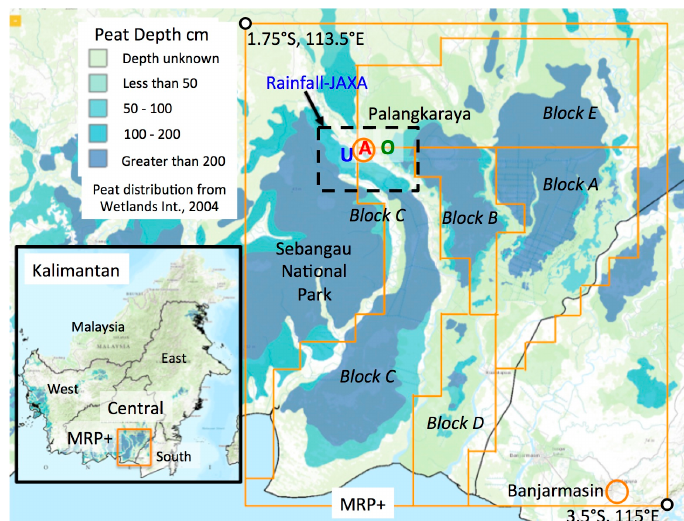
Figure 1. Study area, MRP+ and Kalimantan. mega rice project (MRP)+ cover area: 1.75–3.5 S, 113.5–115 E; A: Tjilik Riwut Meteorology Station (TRMS) (2.226 S, 113.95 E); U: groundwater level (GWL) measured site (2.32 S, 113.9 E); O: OLR reference point (2.21 S, 114 E) ; dotted line rectangle: reference area for JAXA rainfall; base peat depth map: Wetlands International [24]